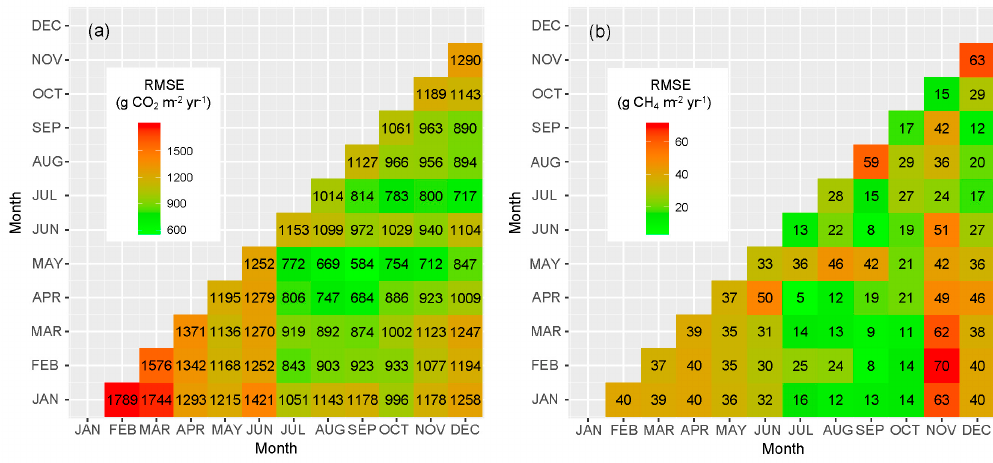
Figure 5. RMSE values for simulations using fluxes from two months of the test data. ( a ) soil/ecosystem respiration; ( b ) CH 4 flux.